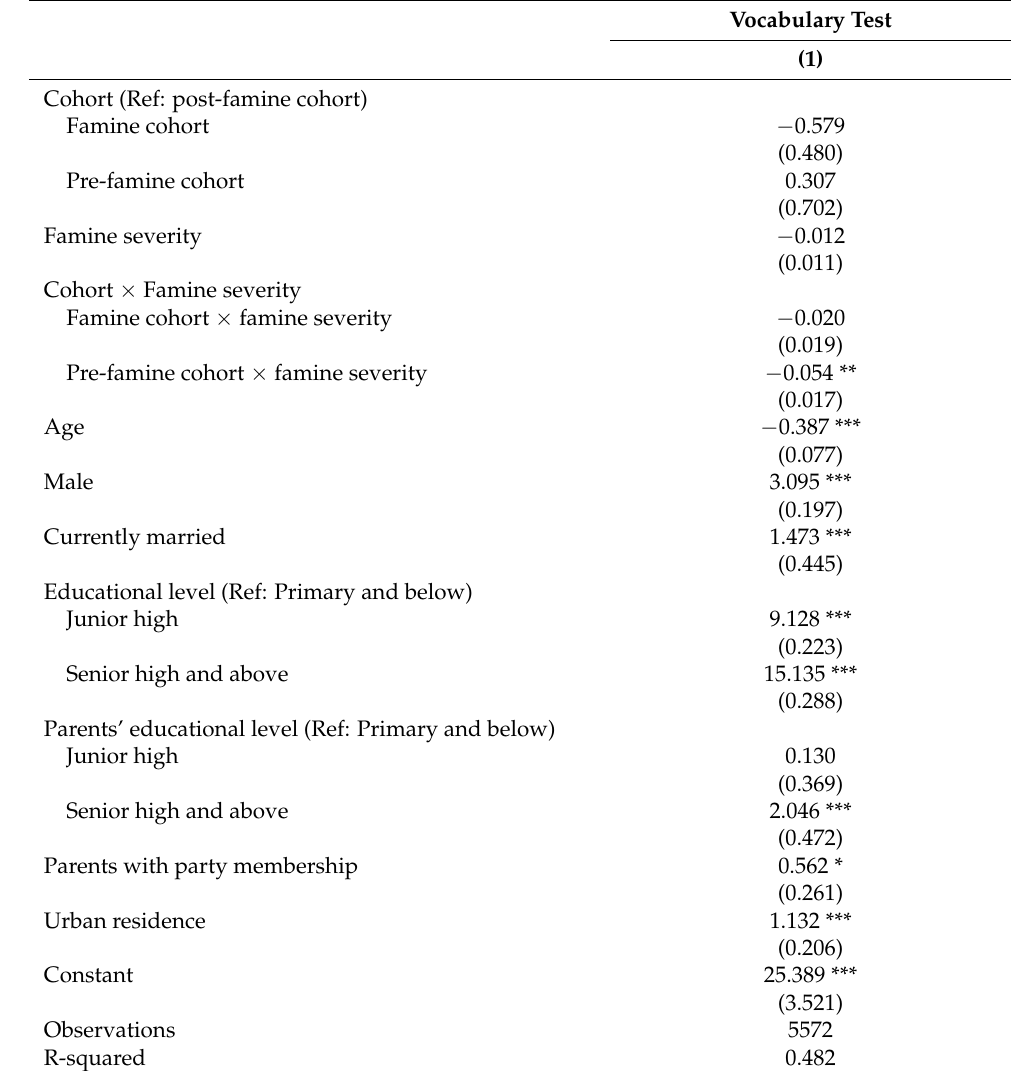
Table 1. Long-term famine effect on people’s vocabulary test (the cohort comparisons approach: DID